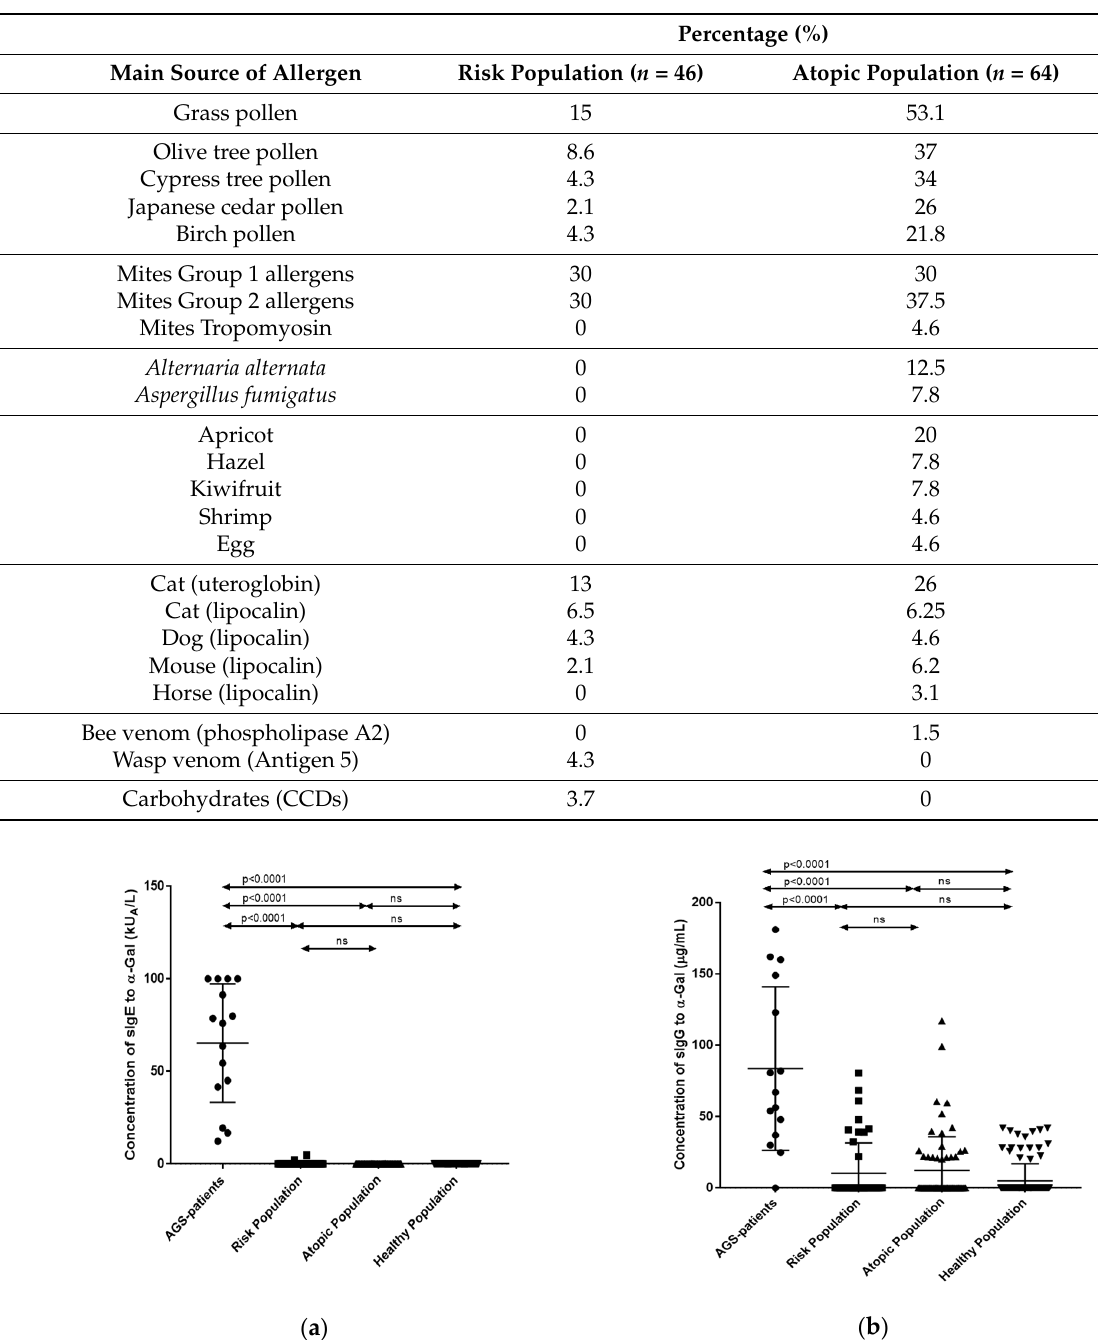
( b ) Figure 2. ROC curve ( a ) and distribution of the studied populations considering 40 µg/mL as sIgG to α -Gal cut-off value ( b ). In this case, the statistical analysis showed no differences between the AGS patient group and the risk-population group included in this study ( p > 0.999). Statistically sig- nificate differences were demonstrated among AGS patients and the atopic population and healthy population ( p = 0.002 and p = 0.001, respectively). A contingency analysis was performed to assess the association between the likelihood of suffering AGS and the sIgG levels to α -Gal. The statistical analysis showed a likelihood of 35% of suffering AGS when the sIgG to α -Gal was greater than or equal to 40 µg/mL in people bitten by ticks. The risk for suffering AGS was increased by 17.5 times (CI 6.333–50.271) when sIgG values to α - 0